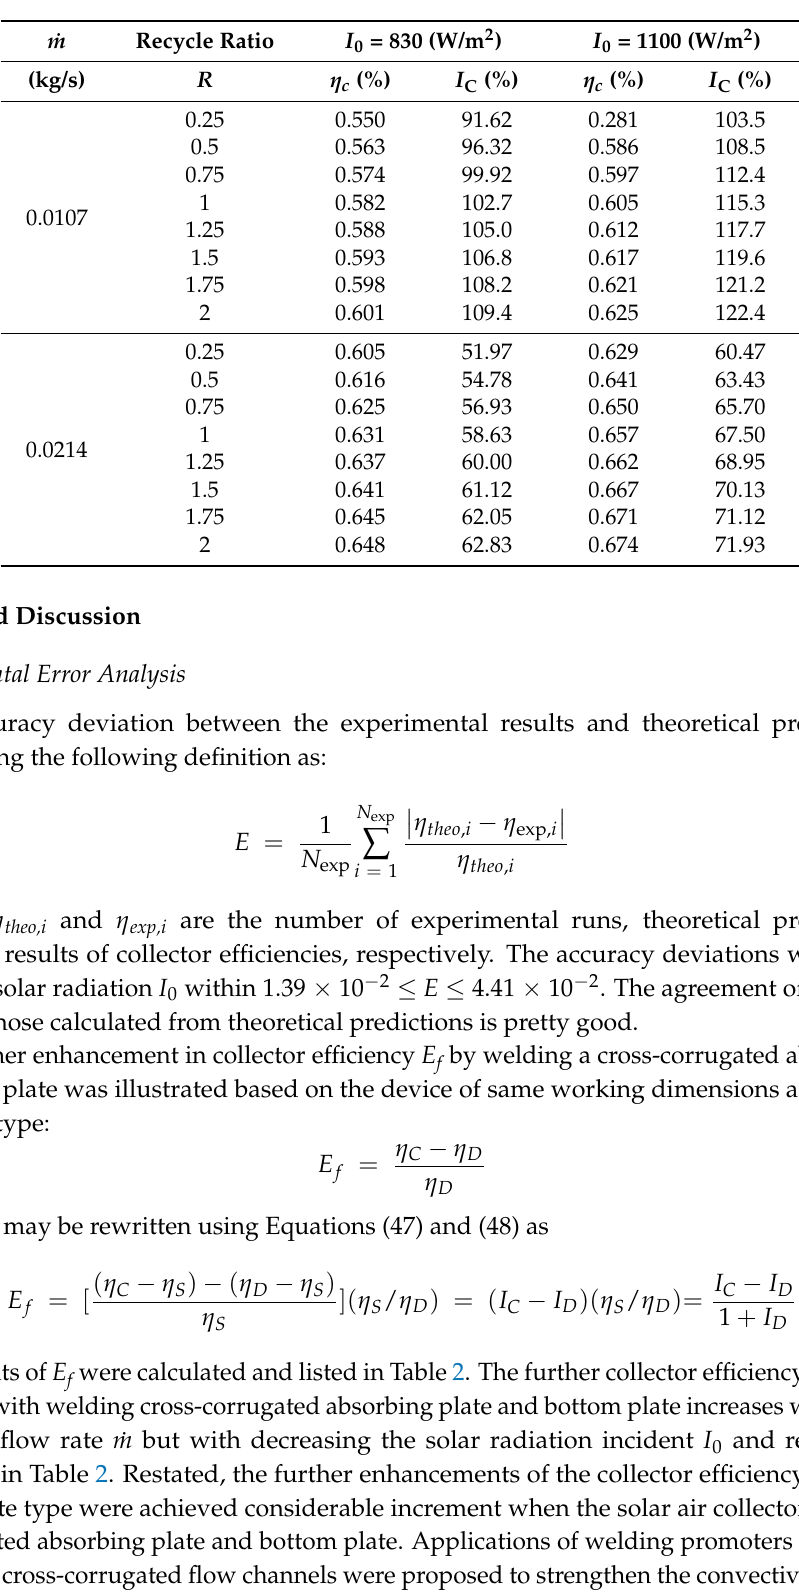
Table 1. Theoretical predictions of collector efficiency η c and improvement I C for I 0 = 830 W/m 2 and I 0 = 1100 W/m 2